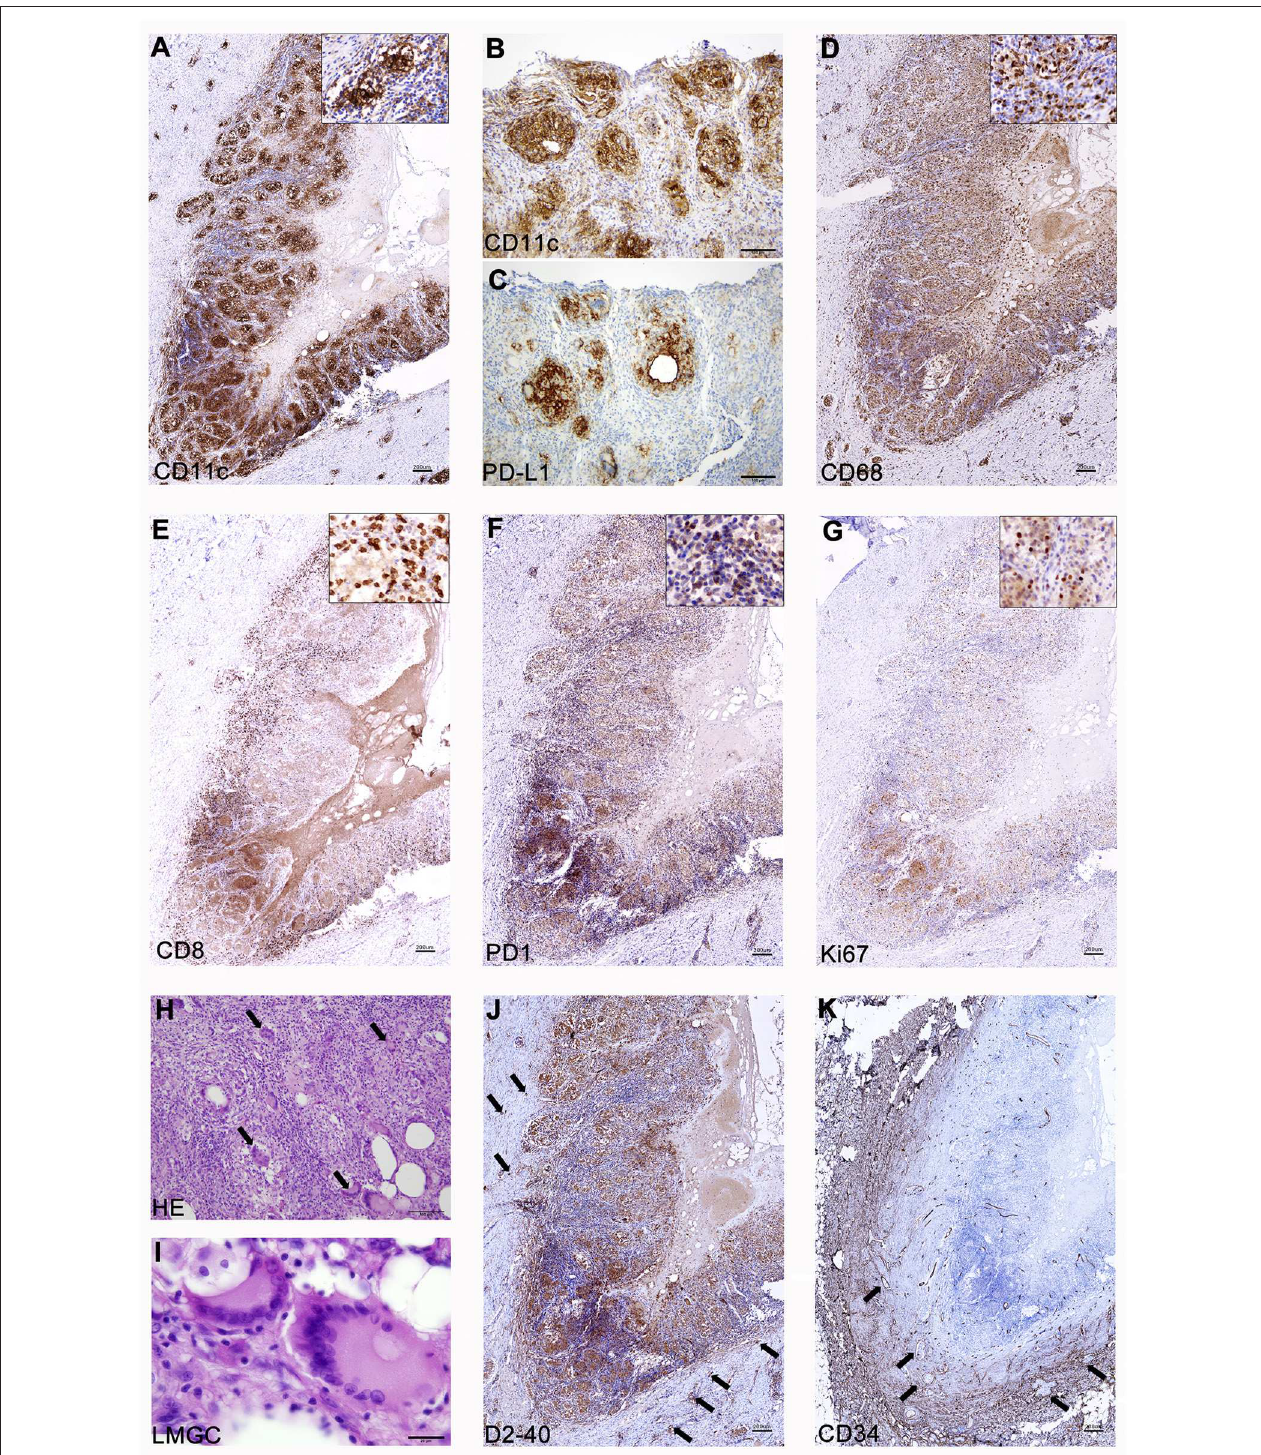
FIGURE 1 | Analysis of a CSF-470 VAC-SITE tissue. (A–C) Dense clusters of CD11c + cells were observed at the VAC-SITE, most of them also expressing PD-L1; (D) Abundant CD68 + macrophages were also present in the area. (E–G) CD8 + lymphocytes were mainly PD1 − and many of them were proliferating (Ki67 + ). (H,I) Numerous LMGC were observed by HE staining (arrows). (J,K) The VAC-SITE was surrounded by numerous lymphatic and blood vessels (arrows). Original magnifications = (A,D–G,J,K) : 20X; (B,C,H) : 100X; (I) : 1000X. Scale bars: (A,D–G,J,K) = 200 µ m; (B,C,H) = 100 µ m; (I) = 20 µ m.